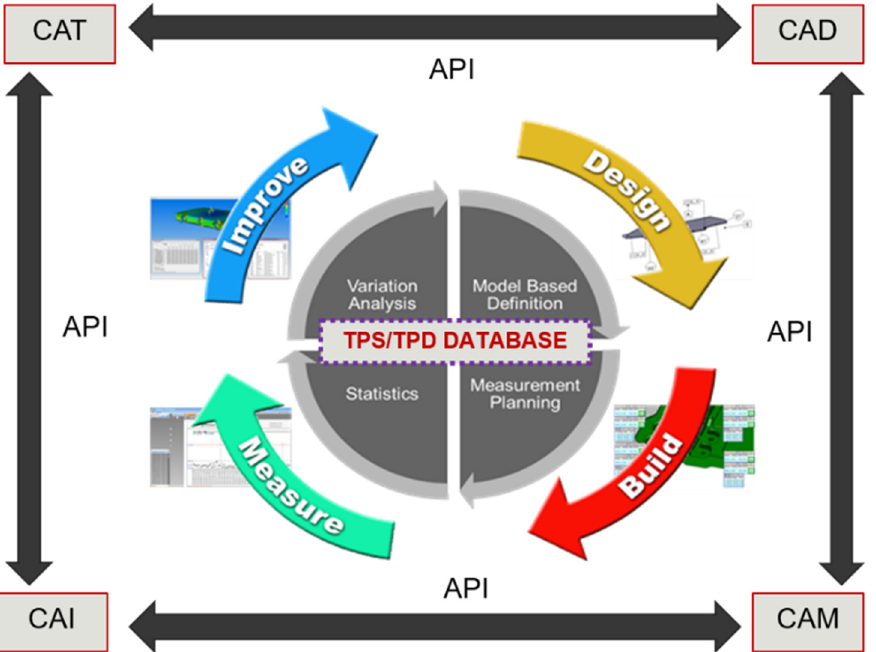
Figure 20. Illustration of a holistic closed-loop, end-to-end, dimensional management, and metrology data and information process based on direct API (Application Protocol Interface) connections. Saab vision and future state.